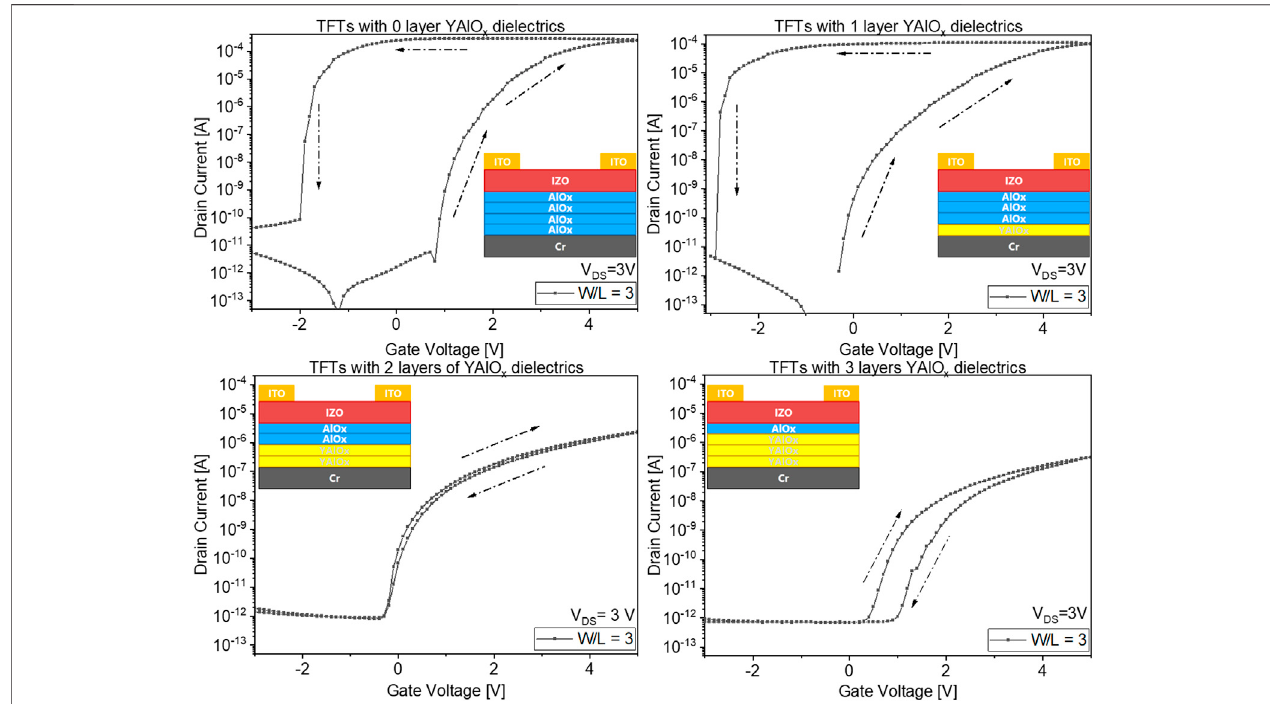
FIGURE 2 | Transfer characteristics of the TFTs with bilayer AlO x /YAlO x dielectrics of alternating layer con fi gurations.